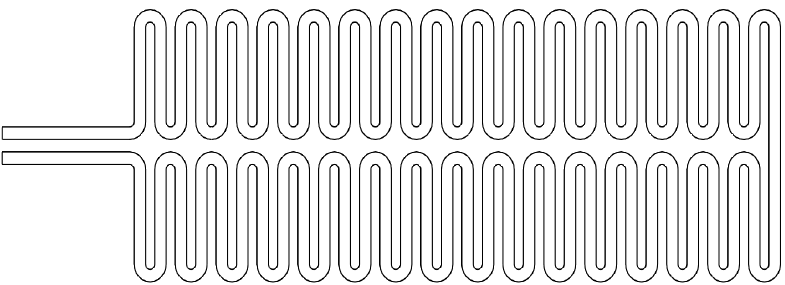
Figure A13. Fabric Design XDP-3. Large double pass design, woven conductive polyester fabric.